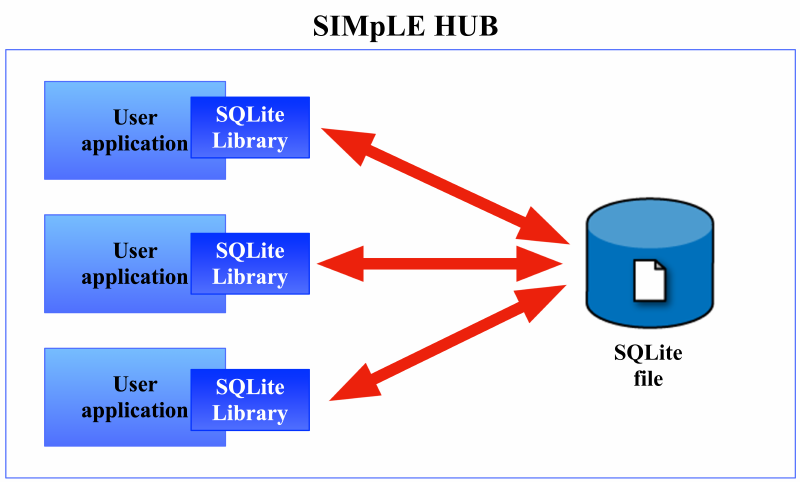
Figure 4. SQLite serverless architecture. The Figure 5 schematically represents the communication between the different